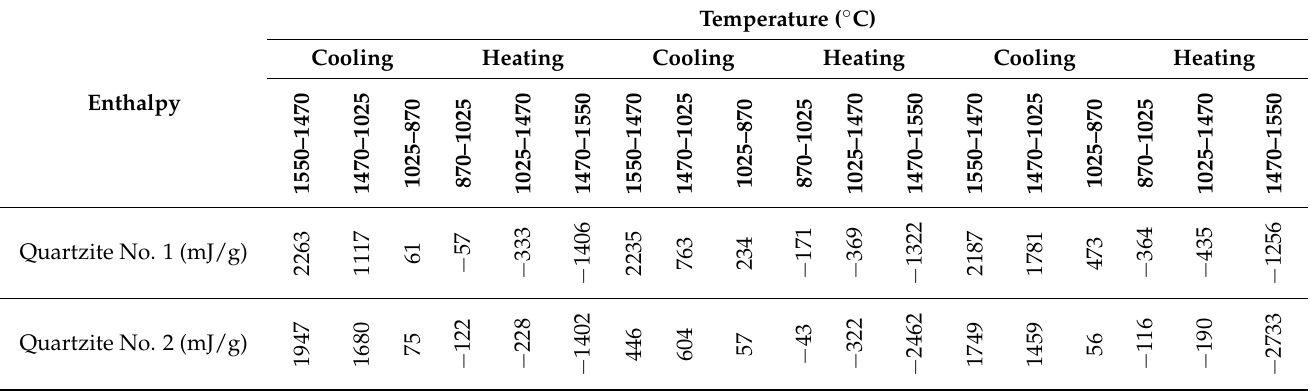
Table 5. The enthalpy values of quartzites at the operating temperatures of melting cycles. No. 1, quartzite treated at 200 °C; No. 2, quartzite treated at 800 °C.